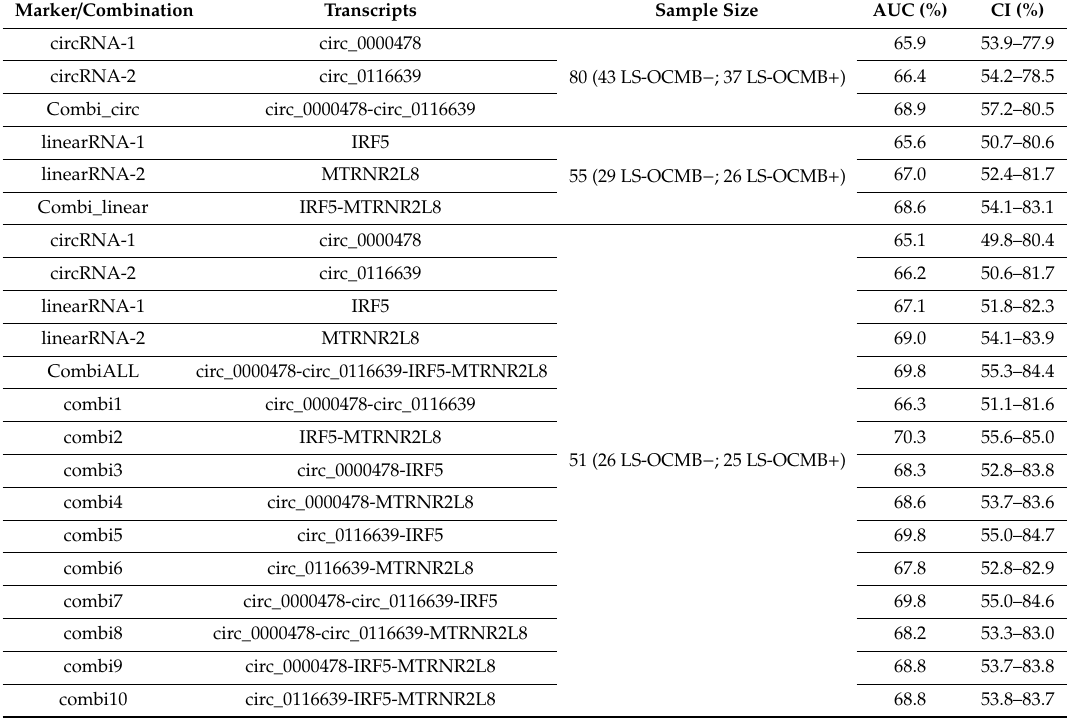
Table 2. ROC analysis results of the four candidate transcripts and different combinations. ROC—receiver operating